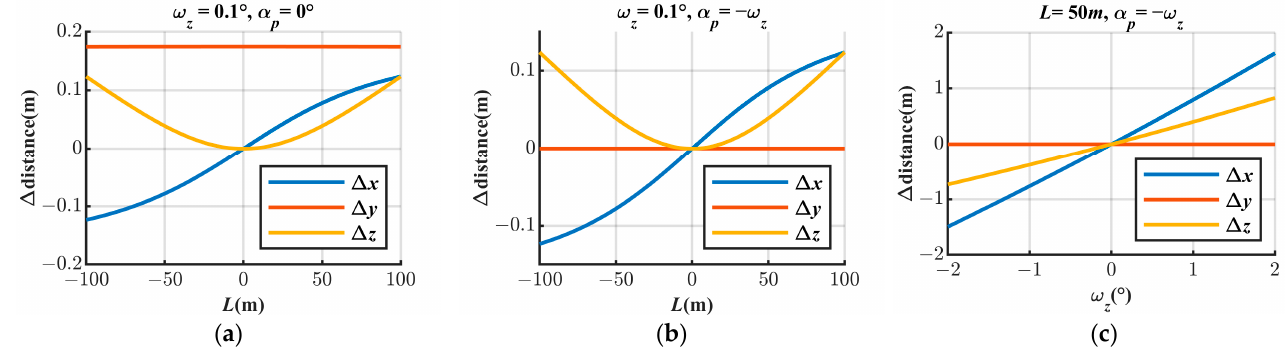
Figure 13. The effect of 𝜔 (cid:3053) on the point coordinates. ( a ) Without 𝛼 (cid:3043) compensation, ∆𝑥 , ∆𝑦 , ∆𝑧 change with 𝐿 ; ( b ) After using pitch angle 𝛼 (cid:3043) compensation, when 𝜔 (cid:3053) = 0.1° , ∆𝑥 , ∆𝑦 , ∆𝑧 change with 𝐿 ; ( c ) After using pitch angle 𝛼 (cid:3043) compensation, when 𝐿 = 50 𝑚 , ∆𝑥 , ∆𝑦 , ∆𝑧 change with 𝜔 (cid:3053) .